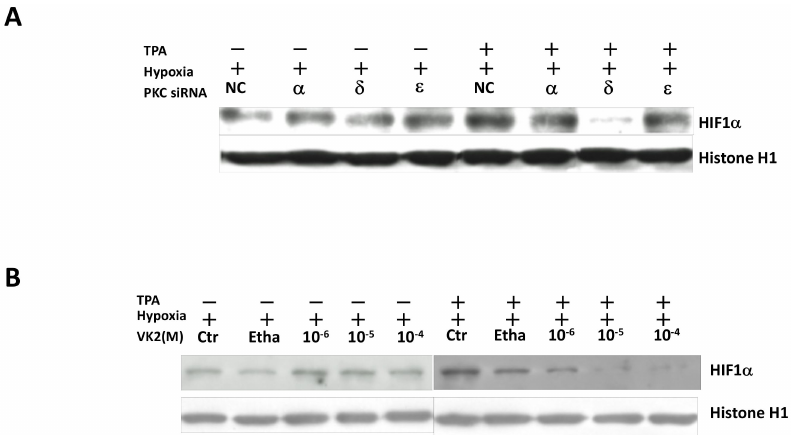
Figure 5. The role of PKC isoforms and the effects of VK2 on the nuclear accumulation of HIF-1 α protein under hypoxic conditions in Huh7 cells. ( A ) TPA induced the nuclear expression of HIF-1a protein in Huh7 cells under hypoxic conditions. The increase in the HIF-1 α protein expression in the nucleus was largely suppressed by the knockdown of PKC- δ not by that of PKC- α or PKC- ε . The cells were treated with PKC siRNAs and incubated for 24 h under hypoxic conditions with or without 50 nM TPA. After treatments, the nuclear proteins were extracted and subjected to Western blotting with specific antibodies, as indicated. Histone H1 was used as nuclear protein loading control. ( B ) VK2 inhibited the nuclear accumulation of HIF-1 α induced by TPA in a dose-dependent manner in Huh7 cells under hypoxic conditions.